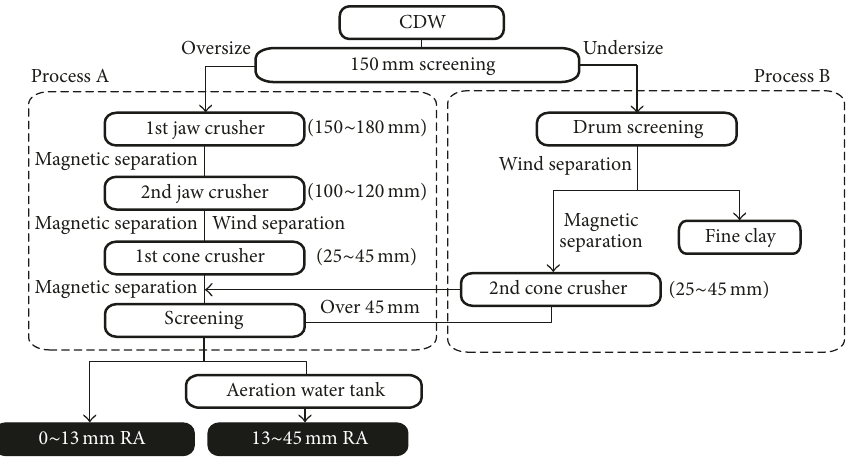
Figure 1: Production process of recycled aggregates in a recycling plant.